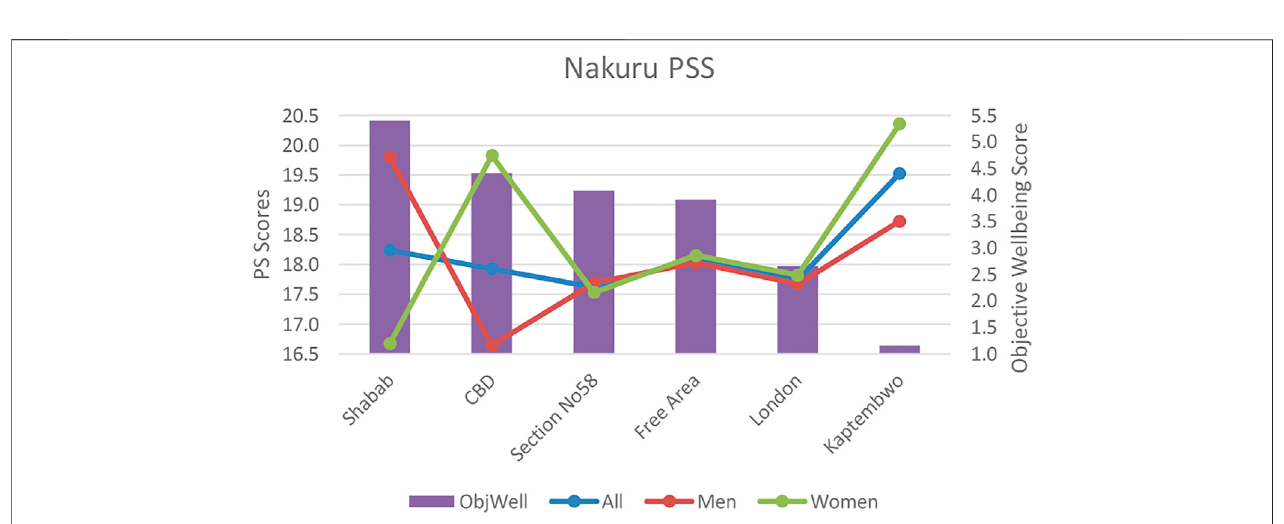
FIGURE 4 | Nakuru perceived stress scale (PSS) scores versus objective wellbeing scores by neighbourhood.